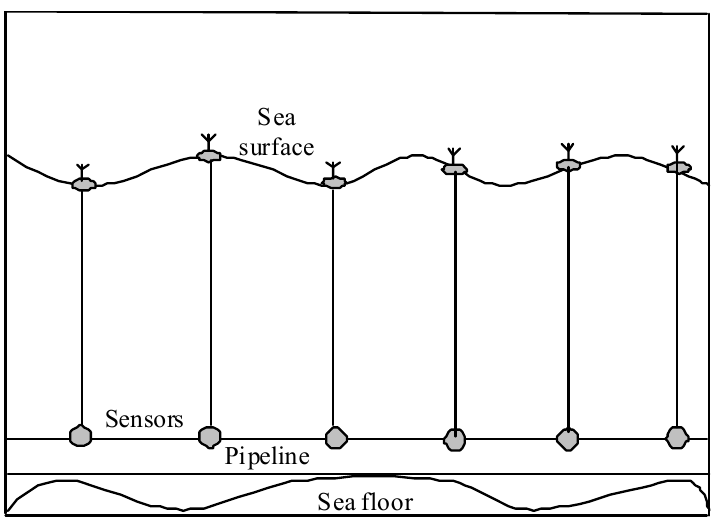
Figure 5. RF Wireless sensor